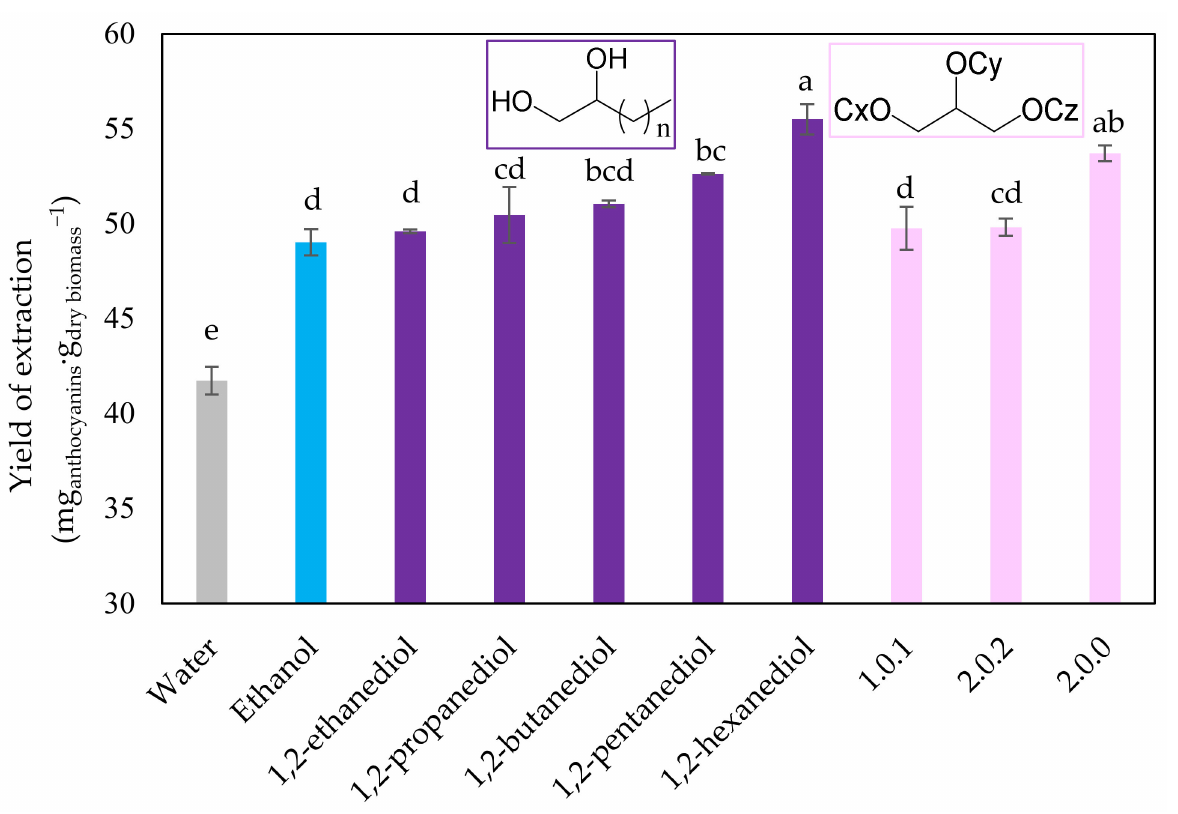
Figure 3. Comparison of different solvents in the extraction of anthocyanins (in terms of yield of extraction in mg anthocyanins · g dry biomass − 1 ) and their corresponding standard deviations. Purple bars represent the 1,2-alkanediols, and light pink bars represent the glycerol ethers studied. Different letters represent statistically different values ( p ≤ 0.10), while the same letters represent statistically equal values ( p > 0.10) by the Tukey test from ANOVA. Table 3. Characterization of the juçara extracts obtained by UAE using different solvents in terms of yield of extraction, TPC, and ABTS and the corresponding standard deviation